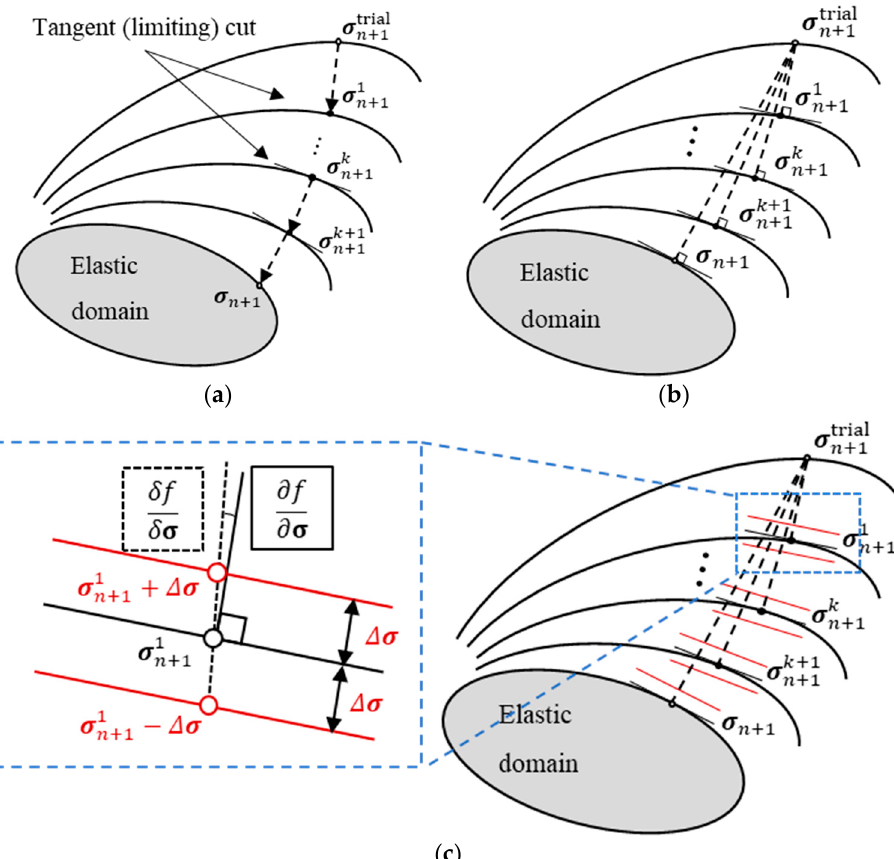
Figure 1. The geometrical interpretations of the implemented algorithms: ( a ) Cutting − plane method (CPM), ( b ) Euler backward method using analytical derivatives (EBM − AD), ( c ) Euler backward method using finite difference method (EBM − ND).